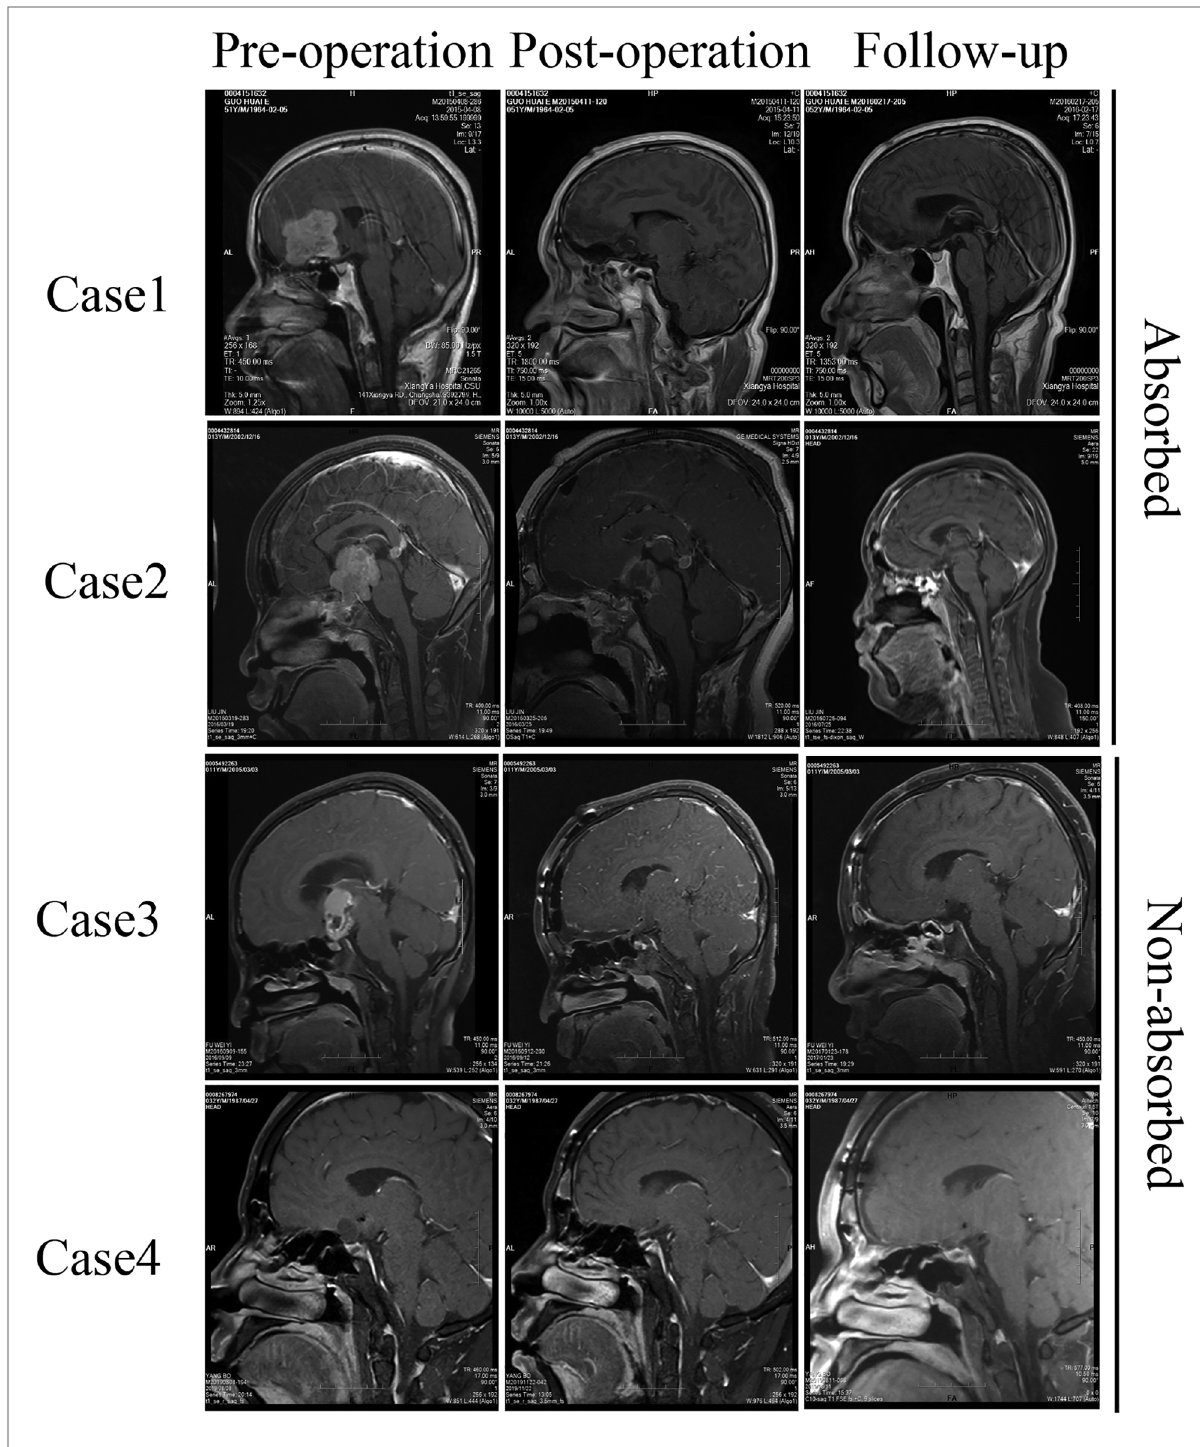
FIGURE 3 Pre/post- operative and follow-up MRI study. The pre-operative MRI showed the lesion at the anterior skull base and the frontal sinus. The post- operative MRI showed the open frontal sinus fi lled with gelfoam. The follow-up MRI showed that the gelfoam was absorbed or not absorbed during